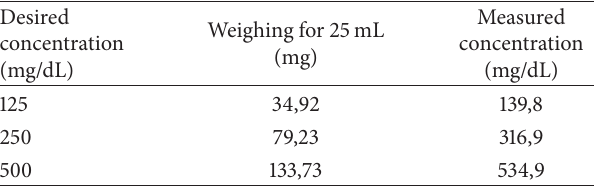
Table 2: Weighing of D-glucose for sample preparation of pig blood-glucose